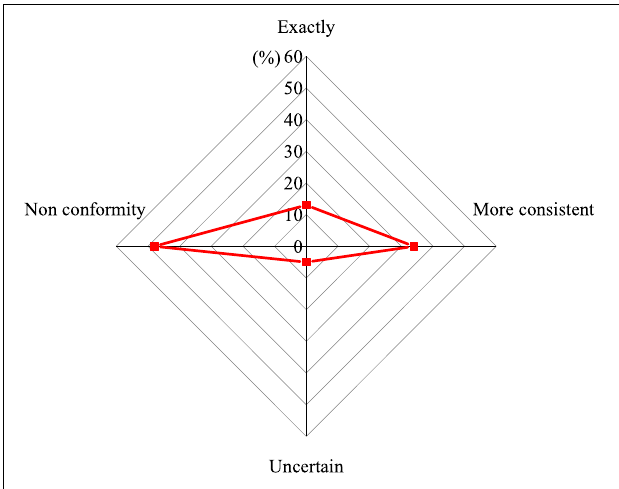
FIGURE 2 | Educational content focuses on the prevention and resolution of students’ psychological problems.